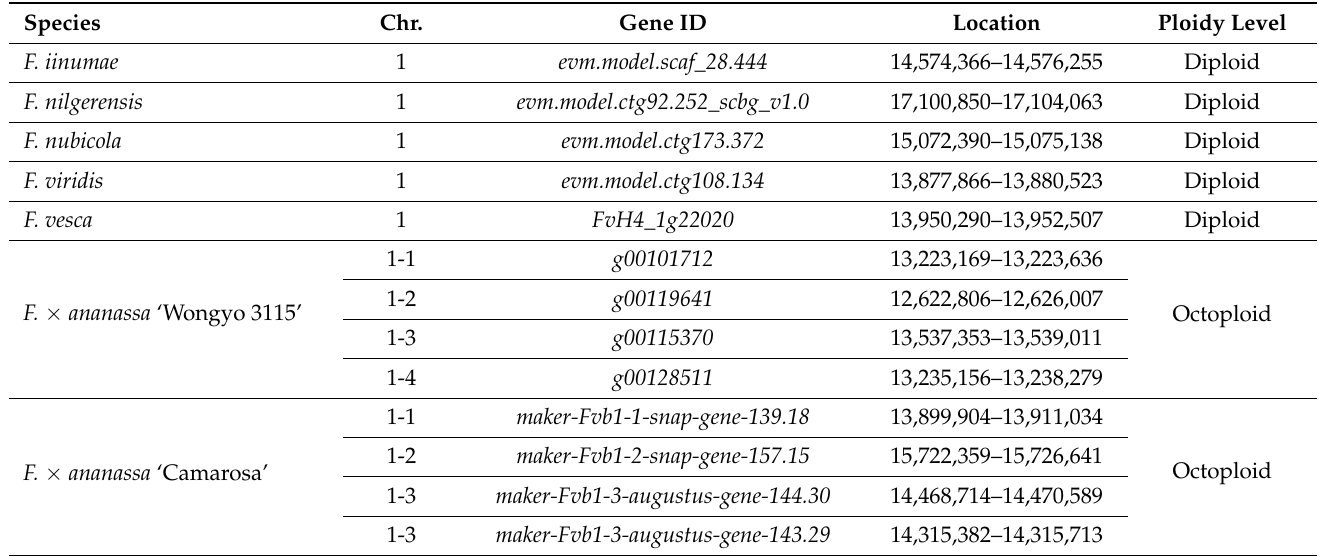
Table 1. Characterization of MYB10 transcription factor in Fragaria.